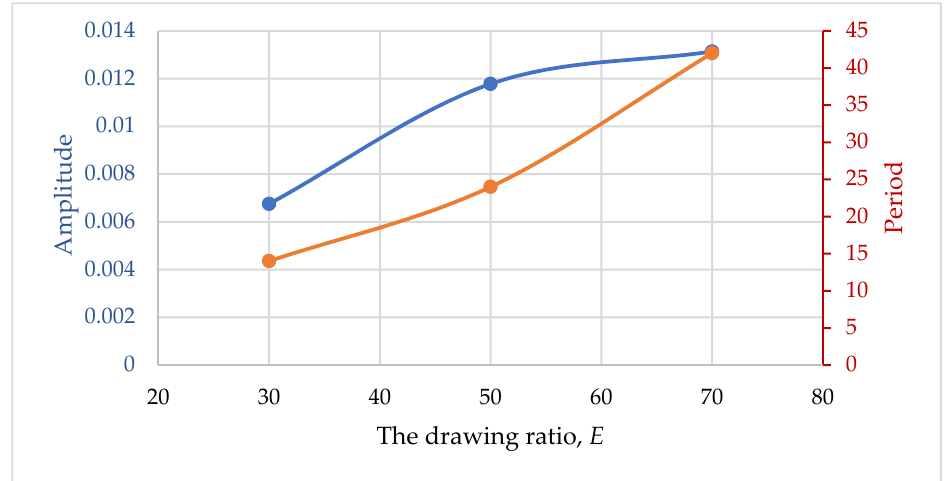
Figure 11. Dependence of the amplitude and period of oscillations on the drawing ratio.